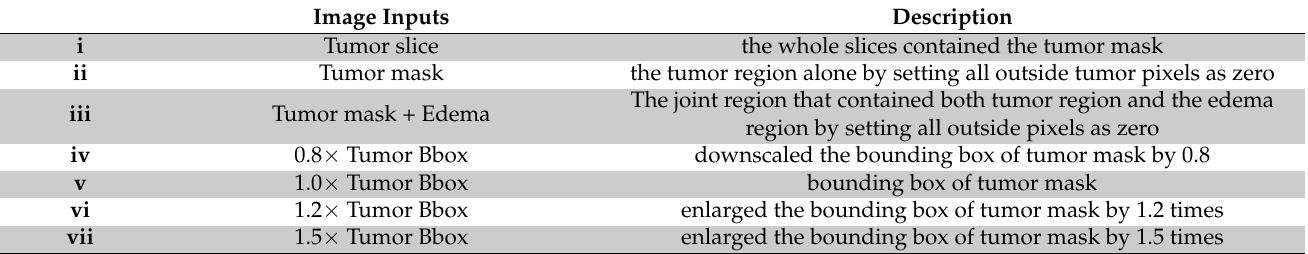
Table 1. Description of the seven pre-processing strategies for the input